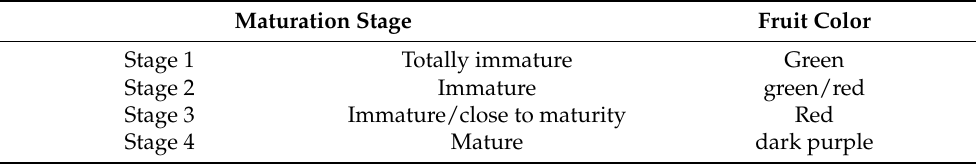
Table 1. Vaccinium stenophyllum Steud. fruit classification according to maturity